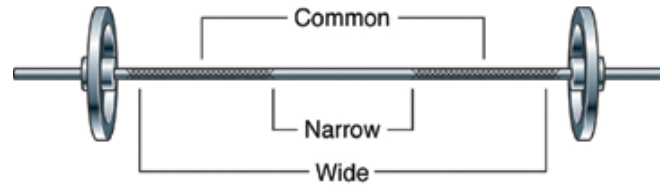
Figure 3-2. Grip Width Landmarks on the